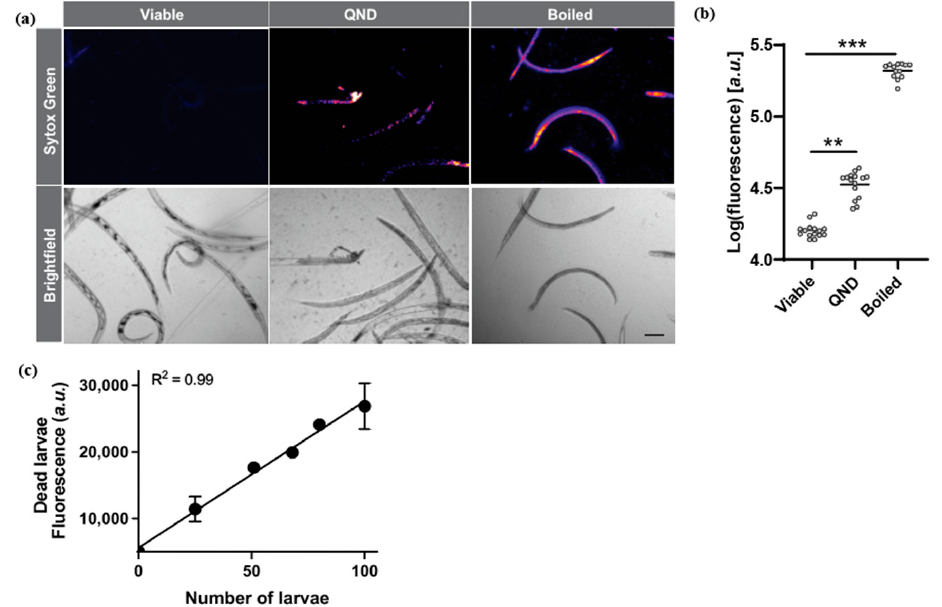
Figure 1. ( a ) Live, quinidine-treated (100 µM, 4 days), or boiled (dead) larvae were exposed to Sytox Green for 24 h prior to microscopic analysis using brightfield or fluorescence emissions. The results were derived from three independent experiments using 100 N. brasiliensis iL3s per well. Fluorescence images were analysed using a look-up-table (LUT) “fire” in Fiji (purple low intensity, yellow high intensity). ( b ) Spectrophotometric measurement of Sytox Green. The fluorescence intensity was log10-transformed. Data were pooled from three independent experiments and analysed using the Kruskal-Wallis test. ( c ) Linear regression analysis of the number of dead iL3 and Sytox Green fluorescence, measured 24 h after labelling. Data were pooled from three independent experiments and expressed as mean ± standard error of the mean (SEM) ANOVA were performed and post-hoc significance is indicated, ** p < 0.01, *** p < 0.001.